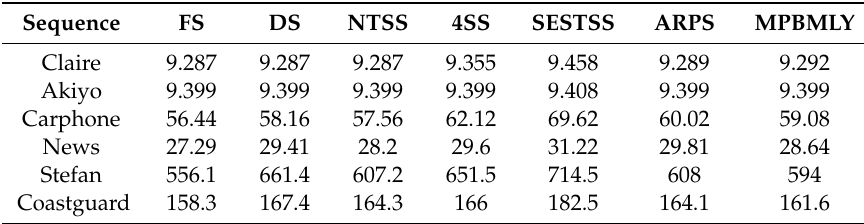
Table 7. Mean MSE for 50 frames.